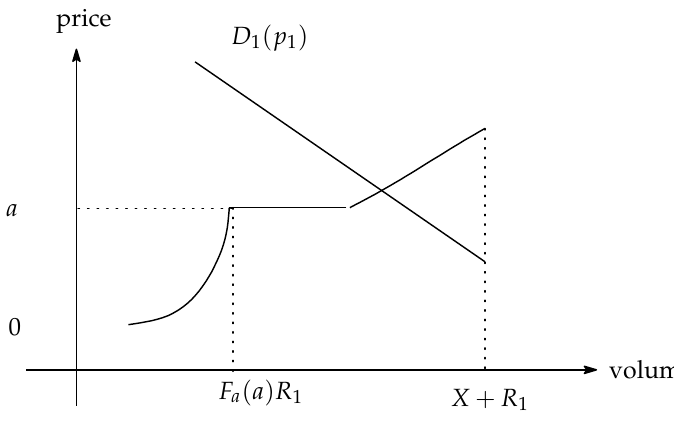
Figure 3. Date 1 Market Equilibrium (Authors’ own drawing) Figure 3. Date 1 market